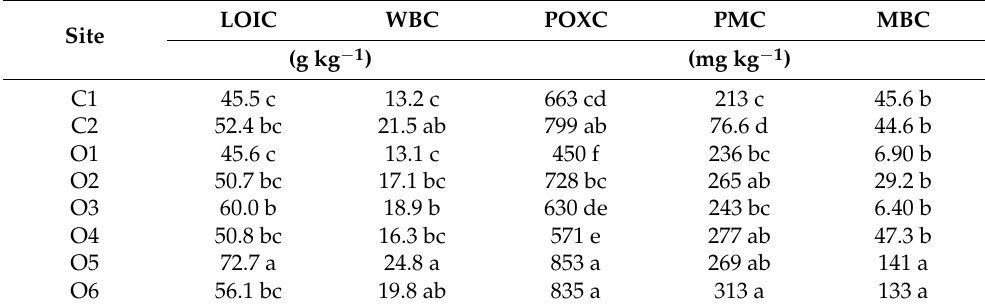
Table 2. Concentrations of soil organic carbon fractions, such as LOIC, WBC, POXC, PMC, and MBC, in paddy soils treated with different fertilization